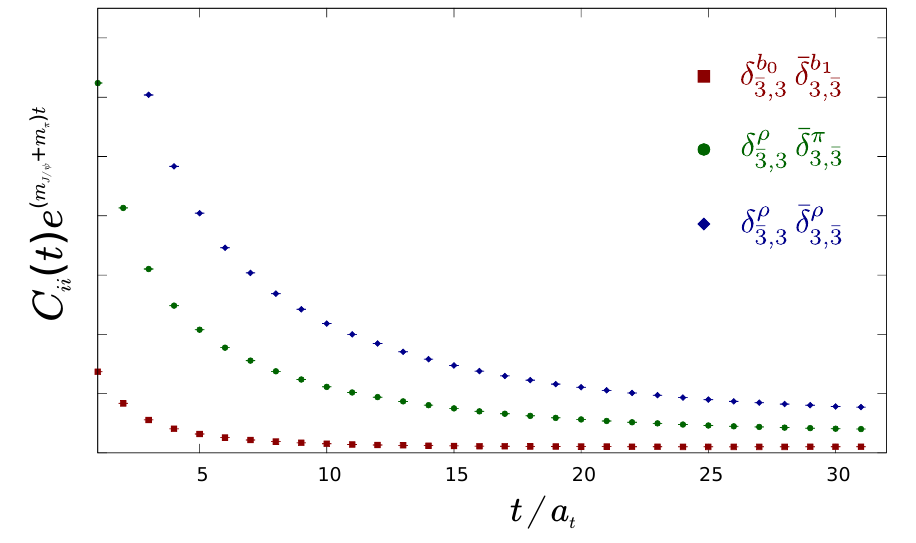
Figure 2 . C ii ( t ) e ( m J= + m (cid:25) ) t in arbitrary units for the tetraquark operators given in the legend in the (cid:3) PG = T ++